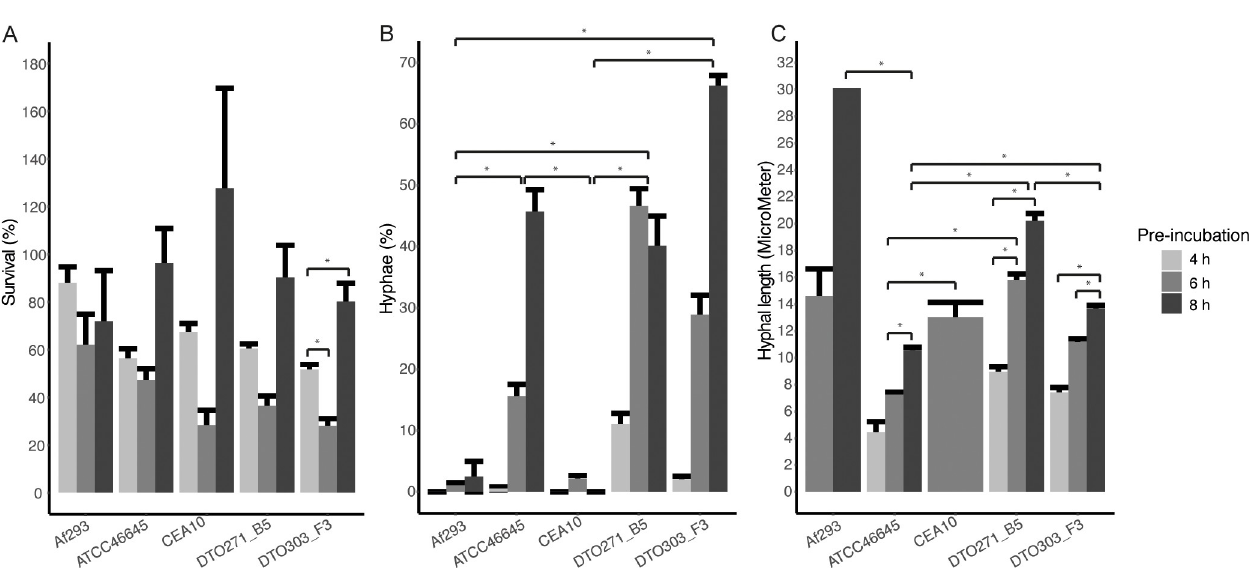
Fig 7. Resistance of A . fumigatus to the predatory phagocyte P . aurantium . Survival, measured by the conversion of resazurin to resorufin (A), hyphal growth (B) and hyphal length ( μ m; C) of conidia following pre-incubation for 4 (light grey), 6 (grey) or 8 h (dark grey) and coincubation with P . aurantium for 18 h. Bars represent the average ( ± SE) of three independent experiments. � indicates statistical significance, survival and hyphal growth is based on a Kruskal Wallis test and the hyphal length is based on a one-way ANOVA, both with a p-value � 0.05.